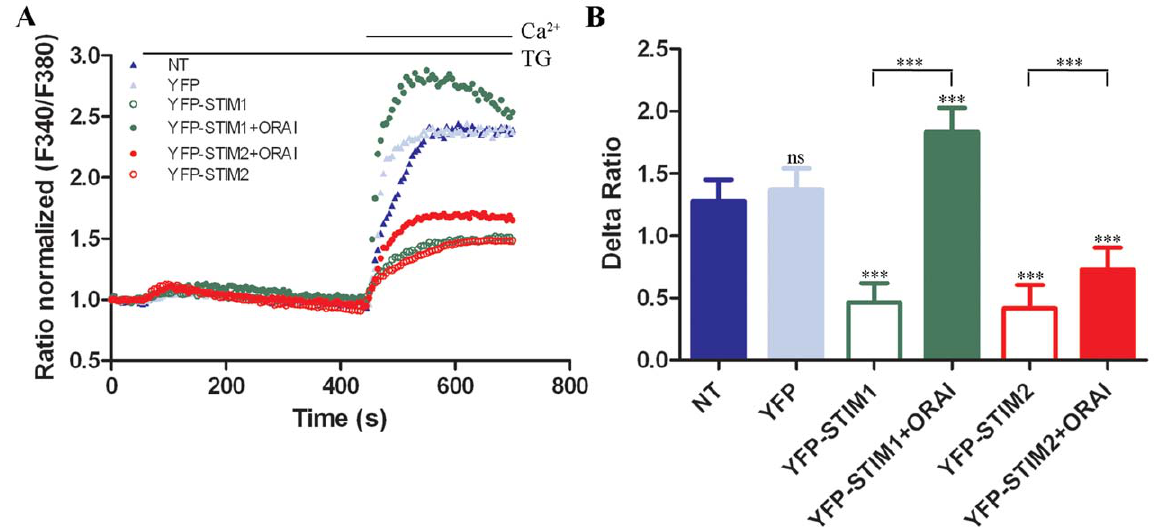
Figure 4. Analysis of SOCE in transfected cortical neurons in response to store depletion by TG . ( A ) Averaged traces from 15–20 cells per trace from at least three experiments of intracellular Ca 2 + (F 340 /F 380 ) levels obtained by ratiometric Fura-2 analysis of neurons overexpressing YFP- STIM1 6 ORAI1, YFP-STIM2 6 ORAI1, YFP, or nontransfected (NT). Measurements were started in a buffer supplemented with 0.5 mM EGTA, which was then replaced by a buffer with 0.5 mM EGTA and 2 m M TG. Finally, 2 mM CaCl 2 was added to the medium to detect Ca 2 + ion entry. F 340 /F 380 values beginning just before the addition of TG were normalized to the same values (1). ( B ) Summary data showing the maximum TG-induced Ca 2 + ion influx in neurons described in ( A ). Data are expressed as the Delta Ratio ( 6 SD), which was calculated as the difference between the peak F 340 / F 380 ratio after extracellular Ca 2 + was added and its level immediately before the addition of Ca 2 + . *** p , 0.001, compared with control (NT); ns, not significant (ANOVA).